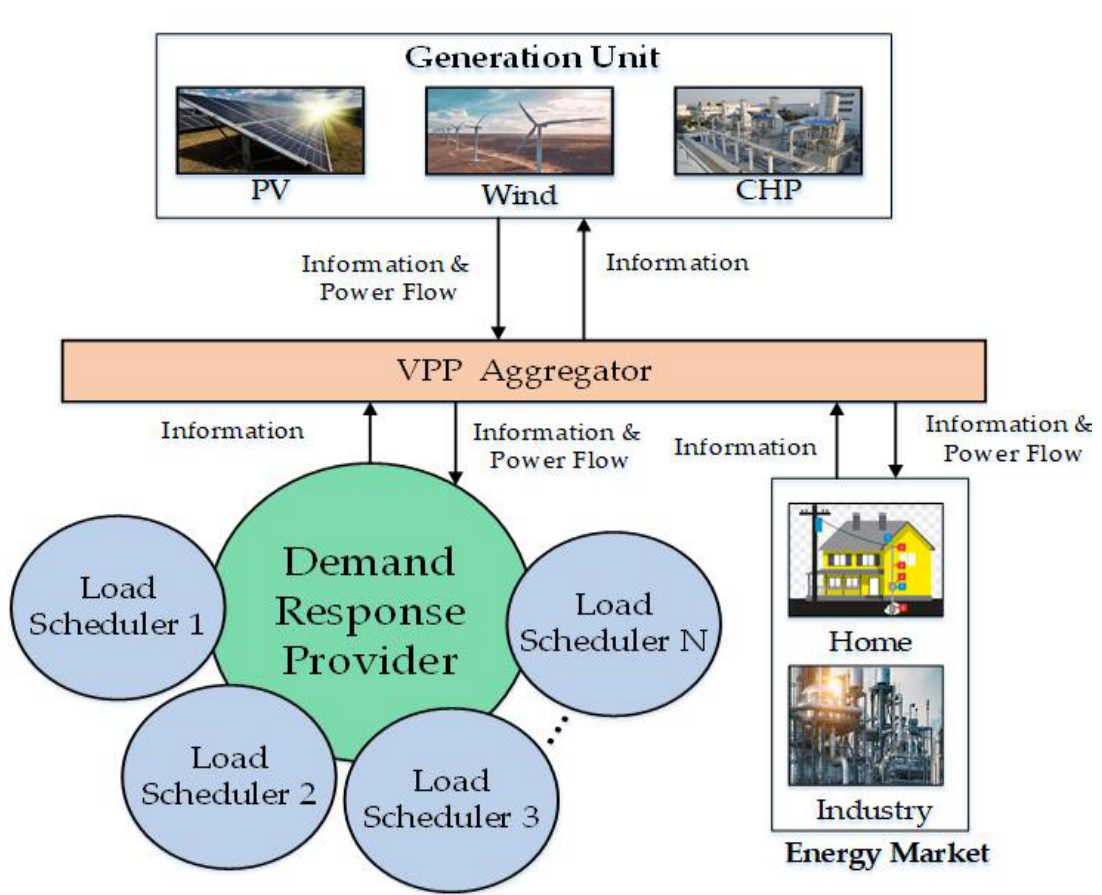
Figure 11. O ff ering optimization model for virtual power plants. (Note: PV-photovoltaics; CHP- combined heat and power; VPP-virtual power